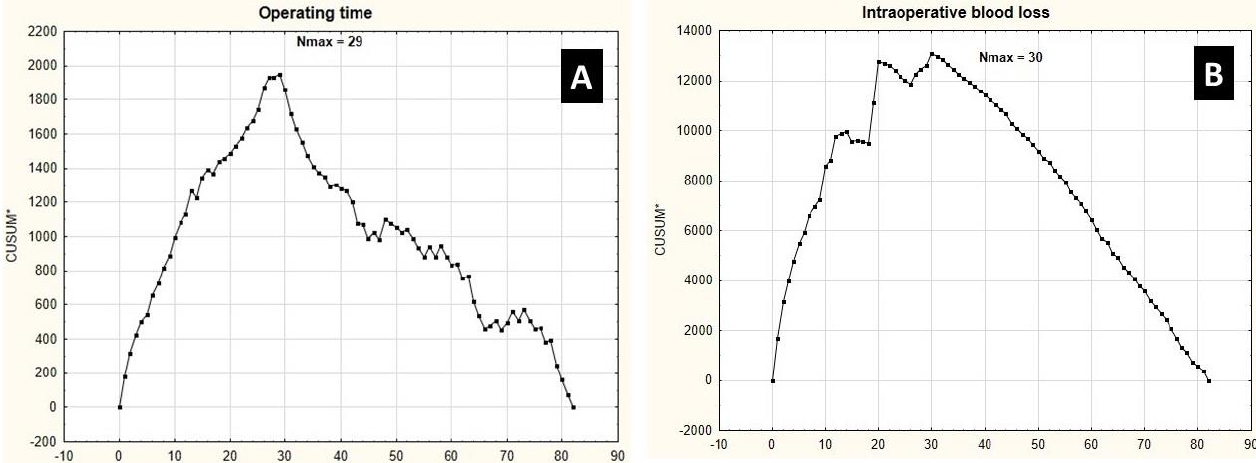
Figure 1. Cumulative sum control chart of operative (CUSUM *) operating time ( A ) and intraoperative blood loss ( B ) against the number of patients.